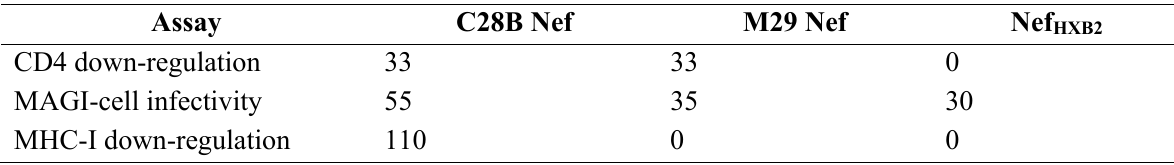
Table 1. Activity of C28B and M29 Nefs in Functional Assays*.